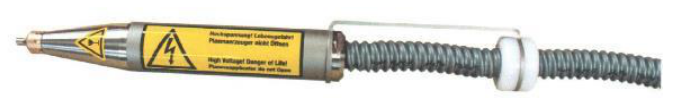
Figure 2. Apparatus used for plasma modification processes — illustrative diagram.